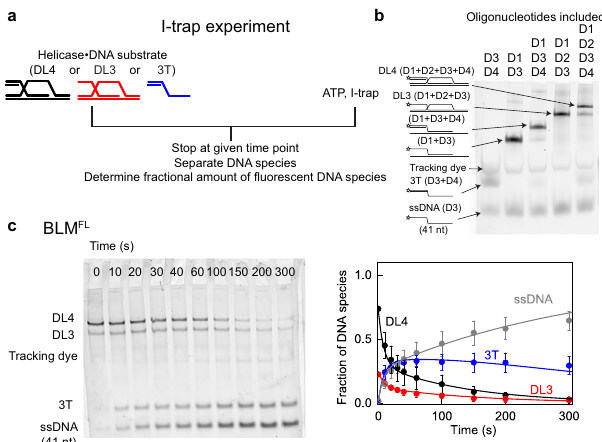
Fig. 2 I-trap method to monitor D-loop processing. a During I-trap D-loop processing experiments, preformed complexes of the given helicase construct with fl uorescently-labeled D-loop-like (4-stranded DL4, or 3-stranded DL3) or 3 ′ -tailed (3 T) DNA substrates (see Methods) were mixed with excess ATP and a large amount of unlabeled ssDNA trap strand (I-trap, homologous to the 3 ′ invading strand of DL4 and DL3) 19 . b Cy3 fl uorometric image of a 12 w/v% native polyacrylamide gel electrophoretogram of DNA species (see Methods) involved in the I-trap DL4-disruption assays. Panel is reproduced from Harami et al. 19 . DL4 preparations contained fractions of DL3, 3 T, and ssDNA. c Example electrophoretogram of a DL4 unwinding experiment with full-length BLM (BLM FL ). Experiments were performed at least three times for individual protein constructs and showed similar kinetic pro fi les. Fractions of DNA species over time were determined by pixel densitometry. Means± SEM are shown for the detected fractions of indicated DNA species at each time point for n = 3 independent experiments with BLM FL (right panel). Lines correspond to global fi ts to the kinetic model shown in Fig. 3. Source data are provided as a Source Data fi